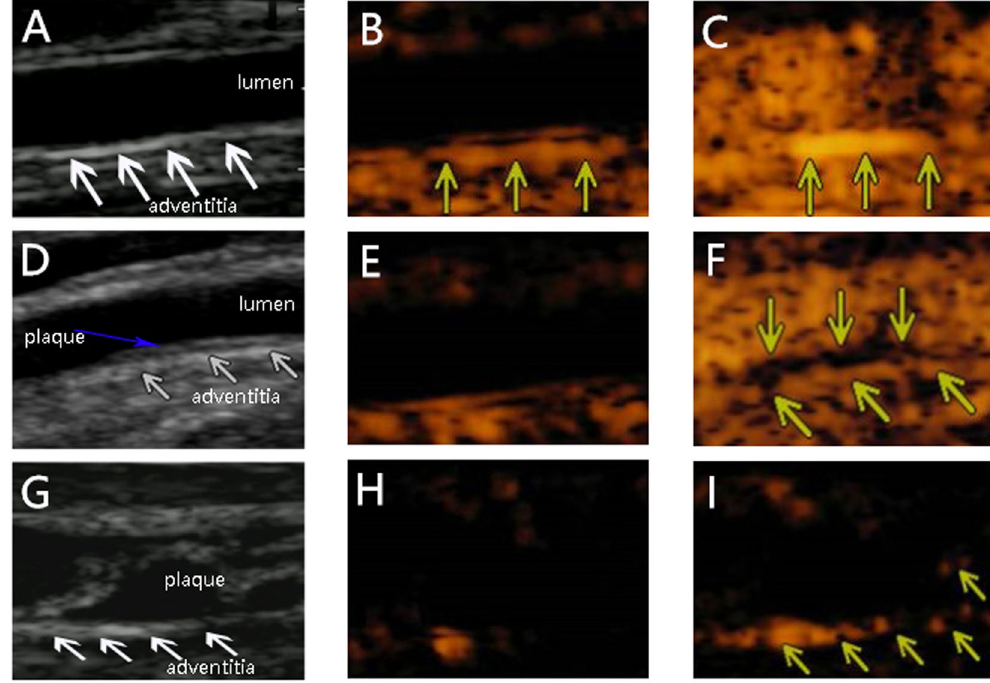
Figure 3. Two-dimensional ultrasound and contrast ultrasound images of the carotid before and after contrast injection. Two-dimensional ultrasound image of the carotid artery clearly shows the adventitia interface and lumen ( A ). The carotid artery lumen was dark before contrast injection, and the outer membrane is clearly visible as indicated by the yellow arrows ( B ). The carotid lumen became immediately visible, and the adventitial also showed enhanced signal after contrast injection, as indicated by the yellow arrows ( C ). There was a small plaque on the wall of the deep region as indicated by the blue arrows ( D ). The carotid artery lumen was dark before contrast injection ( E ). The plaque was a little filling defect, and the outer membrane was visible with more adventitial contrast as indicated by the arrows ( F ). There was a large mixed echo plaque almost filling the lumen ( G ). Before injection of contrast, the carotid artery lumen was dark ( H ). After contrast injection, the outer membrane was obviously enhanced and much more adventitial contrast was visible. There is contrast enhancement inside the plaque as indicated by the yellow arrows ( I ).